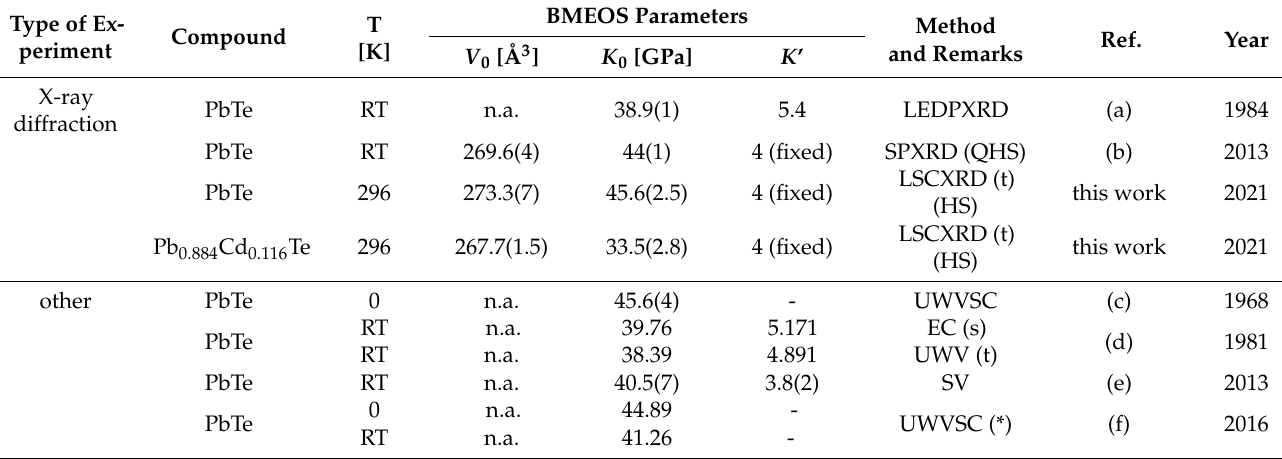
Table 10. Fitted parameters of experimental equation of state for PbTe and Pb 1 − x Cd x Te ( x = 0.116) at various temperatures. Type of